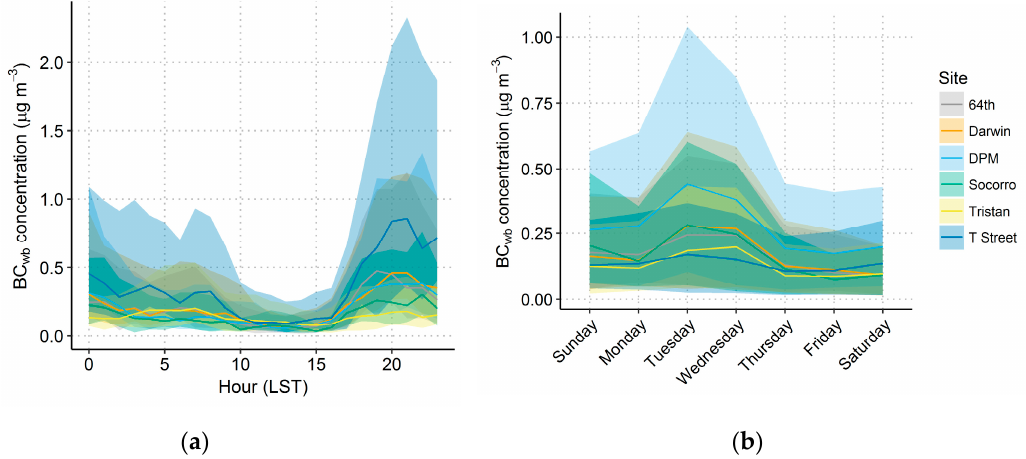
Figure 6. Diurnal ( a ) and day-of-week ( b ) plots for BC wb by site; the median is shown as a line, and the shading indicates the 95th confidence interval around the median. The 95th confidence interval was calculated based on the rank-ordered data values obtained from the binomial quantile function at probabilities of 0.025 and 0.975. DPM: Del Paso Manor.